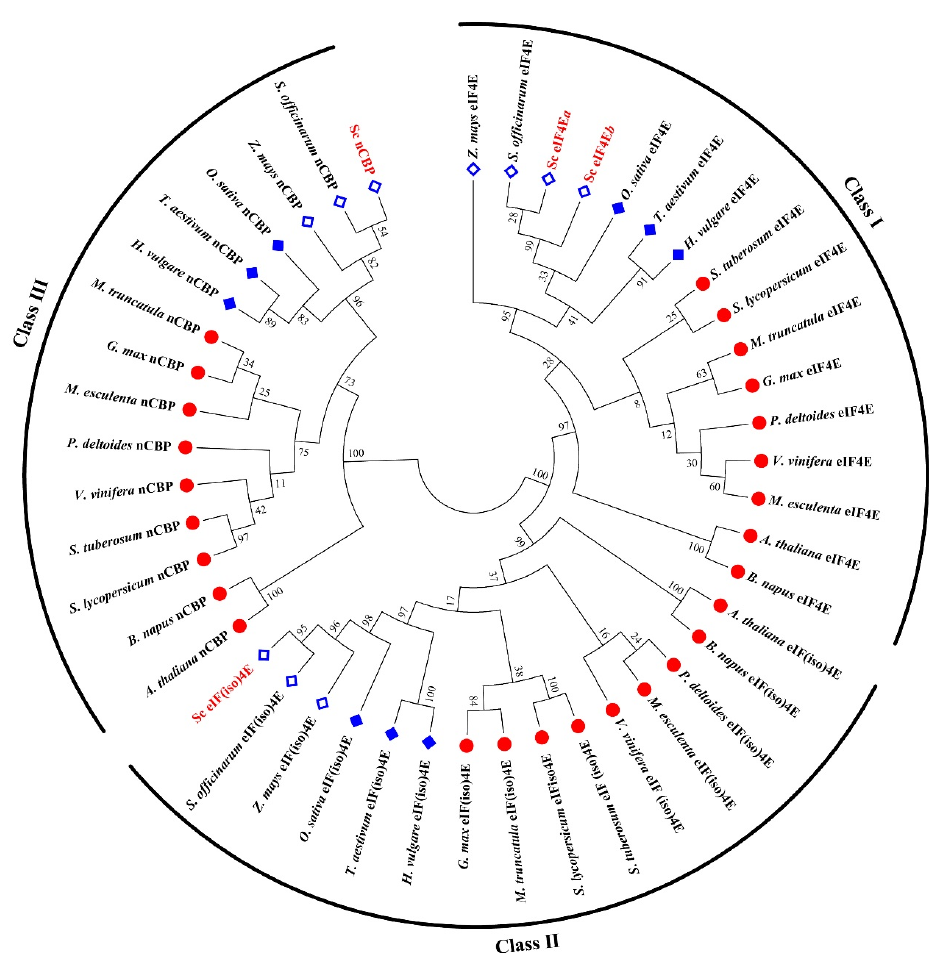
Figure 2. Phylogenetic tree analysis of eIF4E, eIF(iso)4E, and nCBP proteins from different plant species. Protein sequences were retrieved from NCBI and the accession numbers are as follows. Arabidopsis thaliana : eIF4E (AT4G18040), eIF(iso)4E (AT5G35620), nCBP (AT5G18110); Triticum aestivum : eIF4E (CAA78262), eIF(iso)4E (AAA34296), nCBP (XM.037569593);